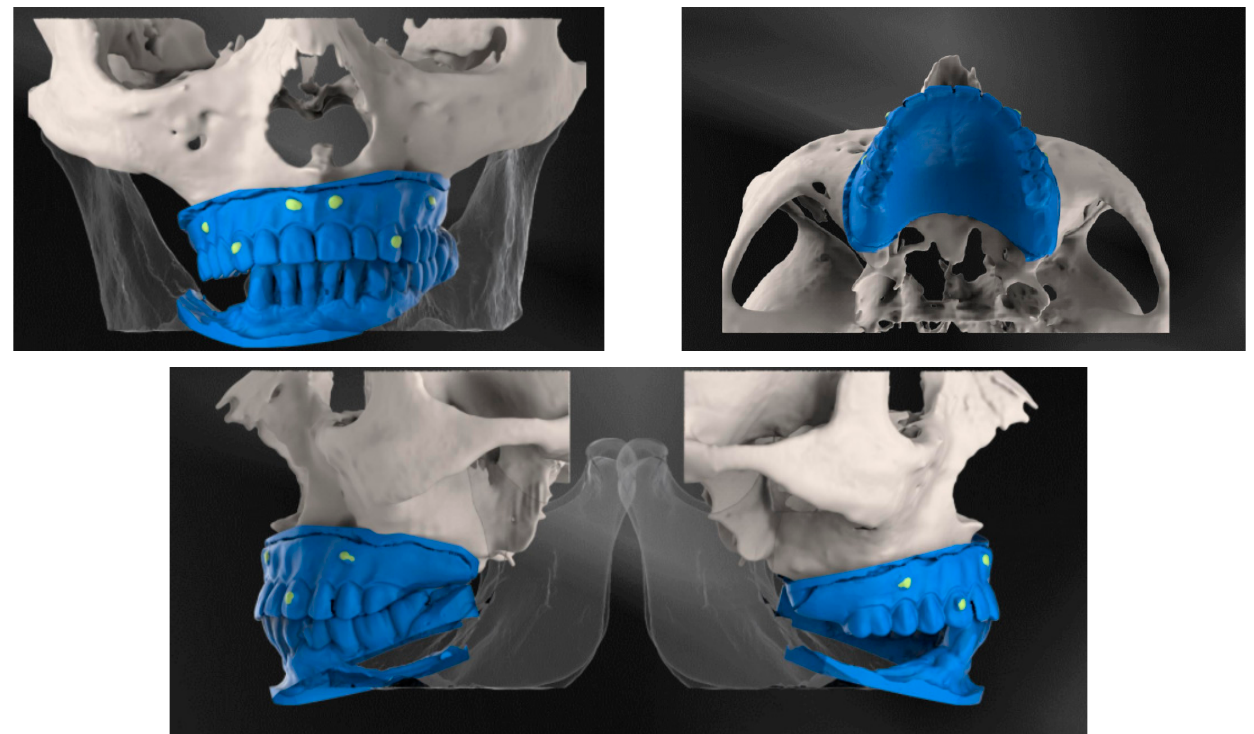
Figure 1. CBCT examination with 3D reconstructions with the maxillary prosthesis.